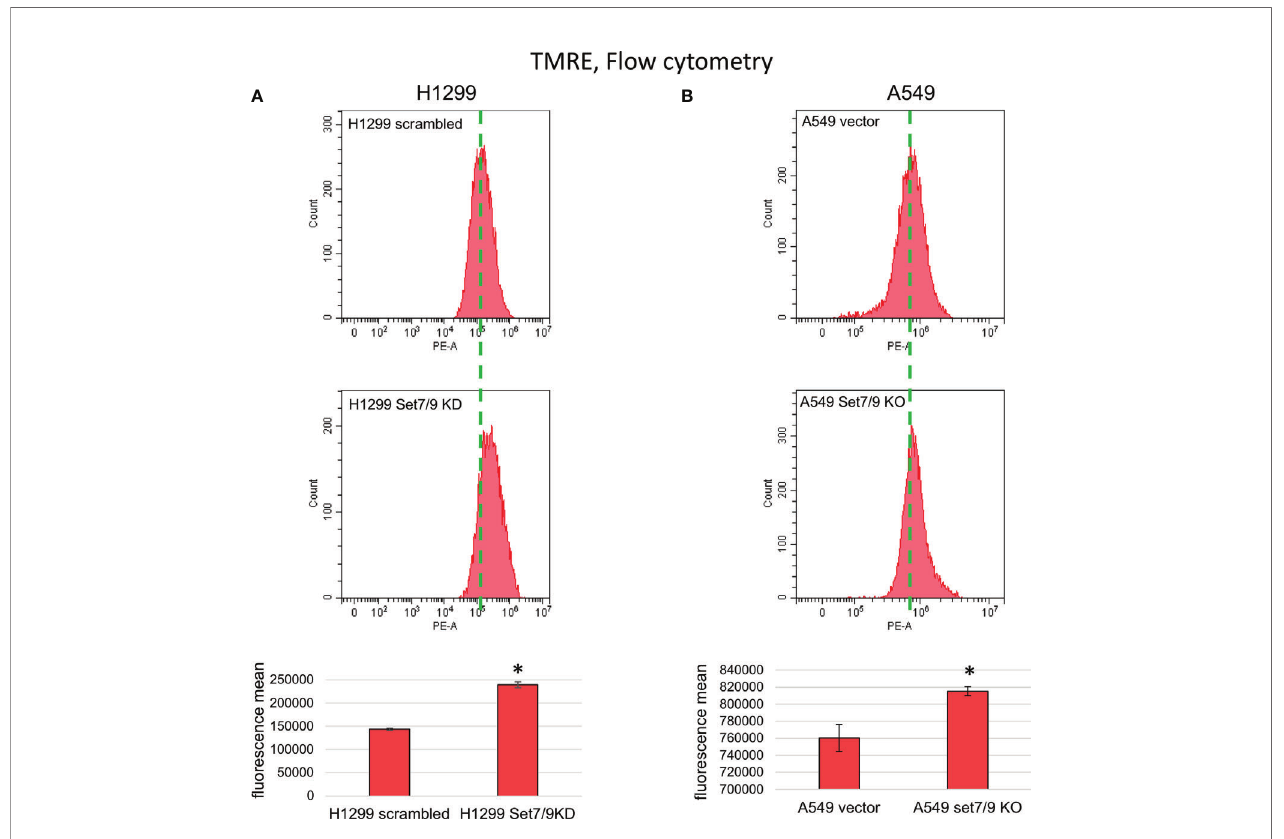
FIGURE 3 | The effect of Set7/9 decrease on mitochondrial membrane potential (MMP) of NSCLC cell lines H1299, A549 and H1975. FC analysis of TMRE staining of NSCLC cell lines (A) H1299 and (B) A549 with Set7/9 knockdown (Set7/9 KD) and knockout (Set7/9 KO) compared to control (scrambled or vector) cells. *p <